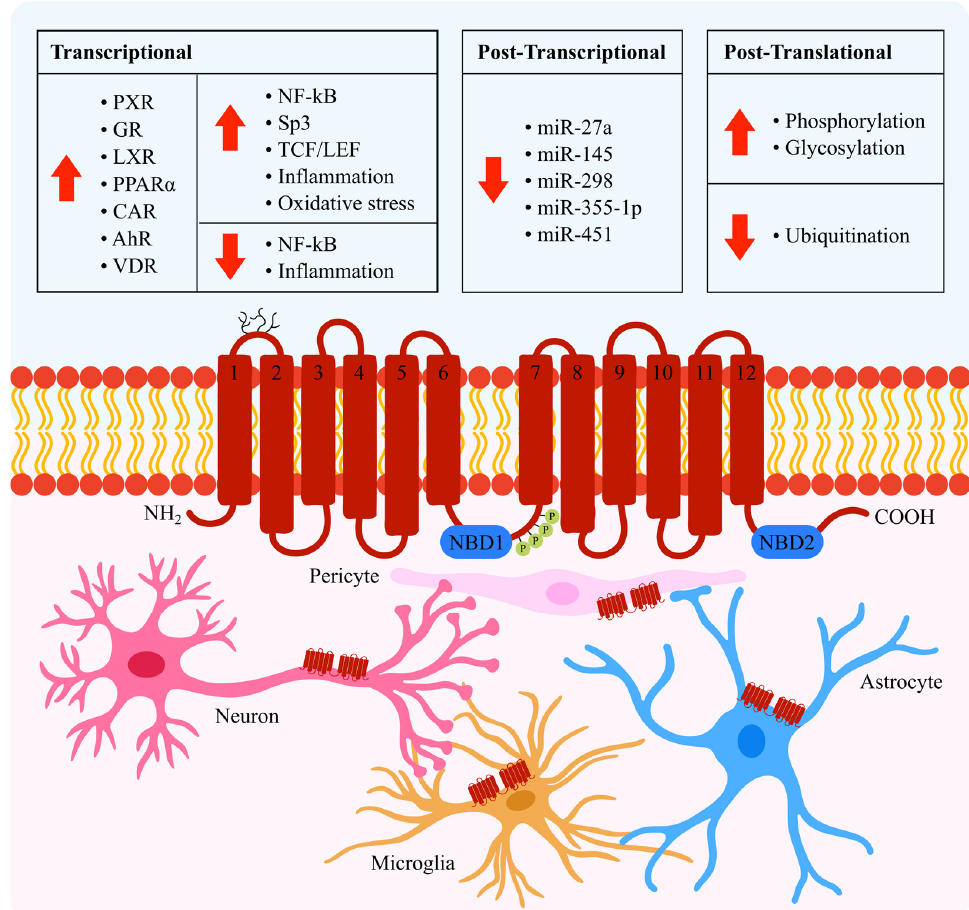
Figure 1. Structure, location and regulation of P-gp in the brain. The P-gp protein consists of two transmembrane domains, each comprising six membrane-spanning helices, and two intracellular ATP-binding regions (nucleotide-binding domains; NBDs). Phosphorylation sites (serine residues S661, S667, S671 and S683 [6]), depicted by green circles, are located within the linker region con- necting the two domains. Glycosylation of P-gp occurs at the asparagine residues N91, N94 and N99 [6], depicted by branched lines between transmembrane helices 1 and 2. In the brain, P-gp is ex- pressed on the luminal surface of BBB endothelial cells. Here, its mRNA and protein expression and activity levels are up- or downregulated by a range of transcription factors, miRNAs and post-trans- lational mechanisms. The expression of P-gp protein has additionally been identified in pericytes, astrocytes [7,8], neurons [7,9] and microglia [10] of the brain.